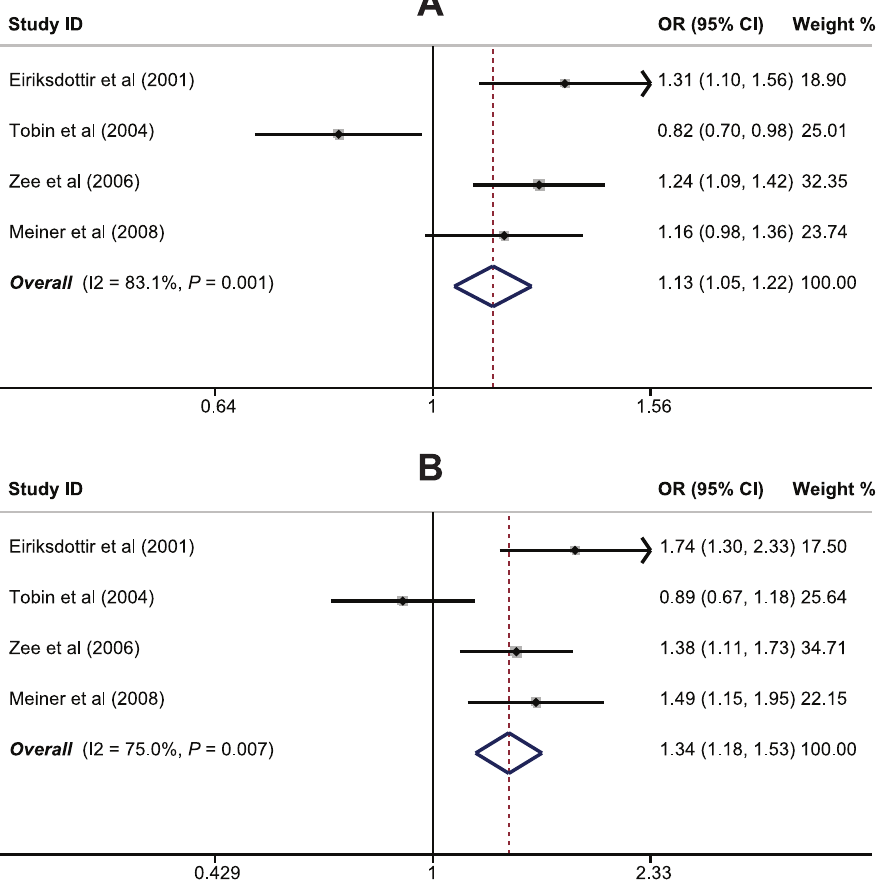
Figure 4. Forest plot of the relationships between CETP rs1800775 (C . A) polymorphism and myocardial infarction risk under the allele and dominant